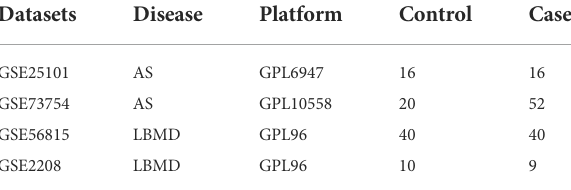
TABLE 1 The information of